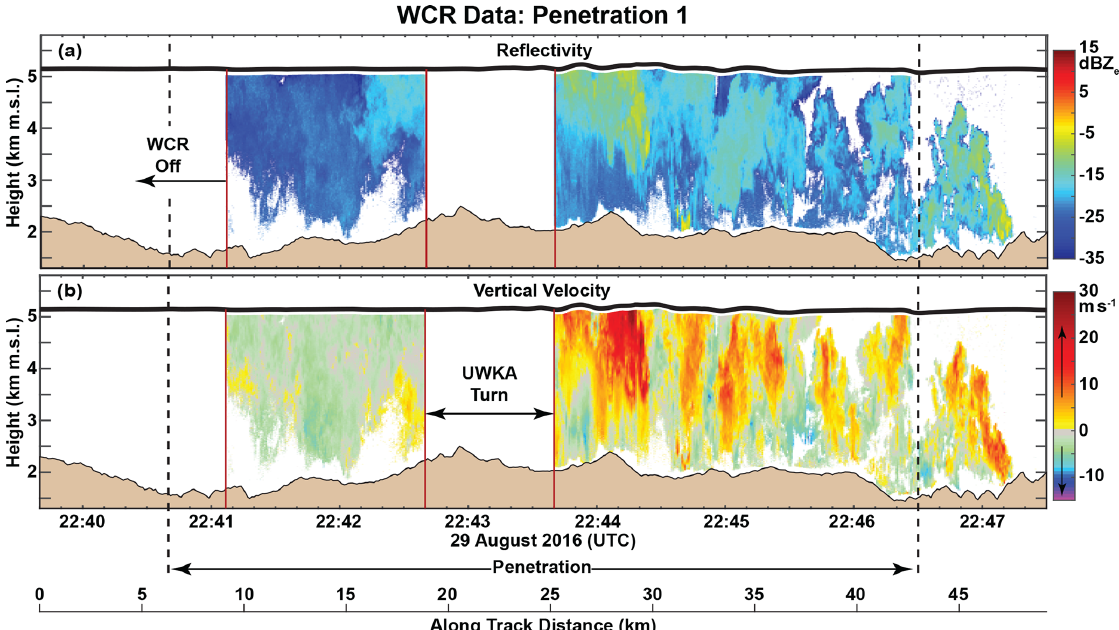
Figure 3. UWKA WCR (a) reflectivity and (b) radial velocity (effectively vertical velocity) data for penetration 1 (Fig. 1d, Table 2) and 60s before and after the penetration (bounded by vertical, dashed black lines). Color scales to the right of each panel indicate plotted values. Aircraft track shown by the bold black lines near the top of each panel. Underlying topography indicated by the filled tan outline at the bottom of each panel. Along-track distance for the penetration shown at bottom. Periods without WCR data bounded by vertical red lines.